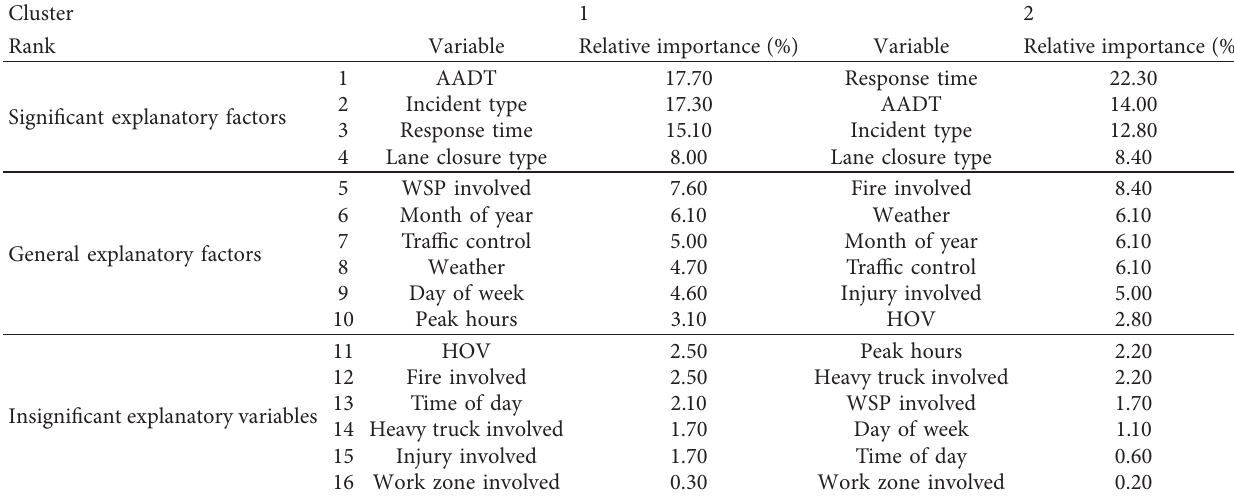
Table 6: Relative importance of explanatory factors on clearance